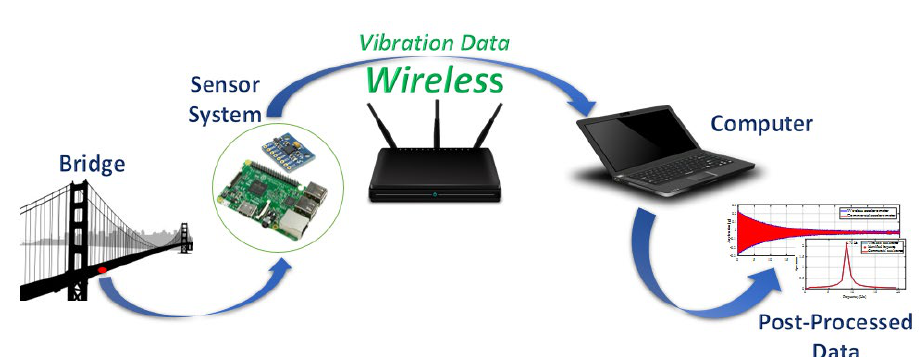
Figure 1. Wireless system schematics.